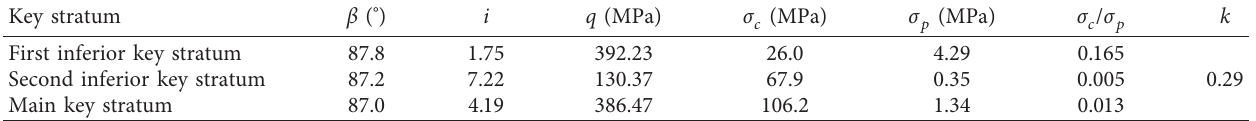
Table 3: Calculation results.